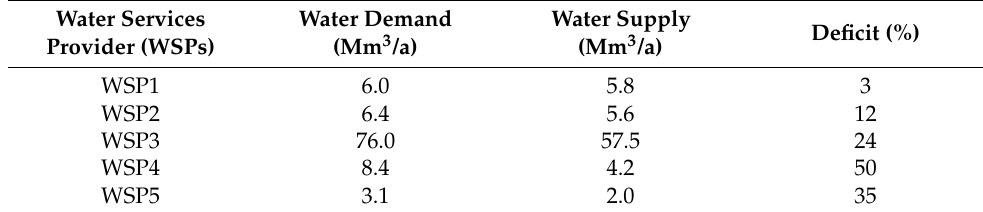
Table 5. Comparison of annual water demand and volume of water supplied and percentage water demand-supply deficit.